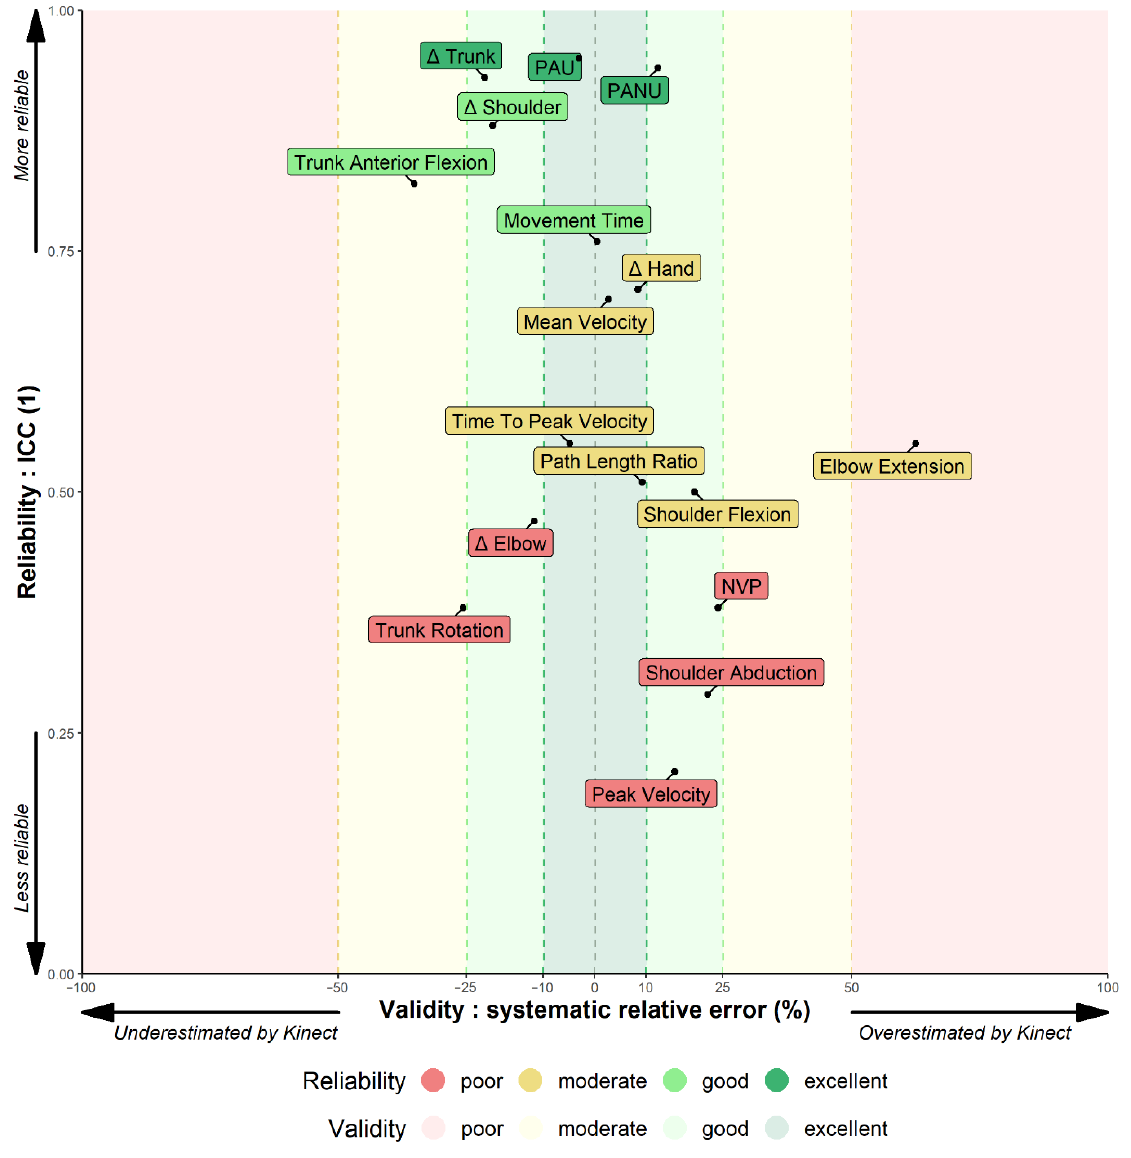
Figure 7. Summary of the validity and reliability of 17 kinematic variables assessed by the Kinect. The X axis represents the validity through the relative error. The Y axis represents the reliability through the one-way ICC. The closer the variable is to the centre on the X axis, the more valid it is. The higher the variable is on the Y axis, the more reliable it is. A perfect match between the Kinect and the Vicon values would place the variable at the centre on the X axis (error = 0) and at the top on the Y axis (ICC = 1). The figure shows that averaged postural and angular measurements are much more reliable than instantaneous Cartesian measures.